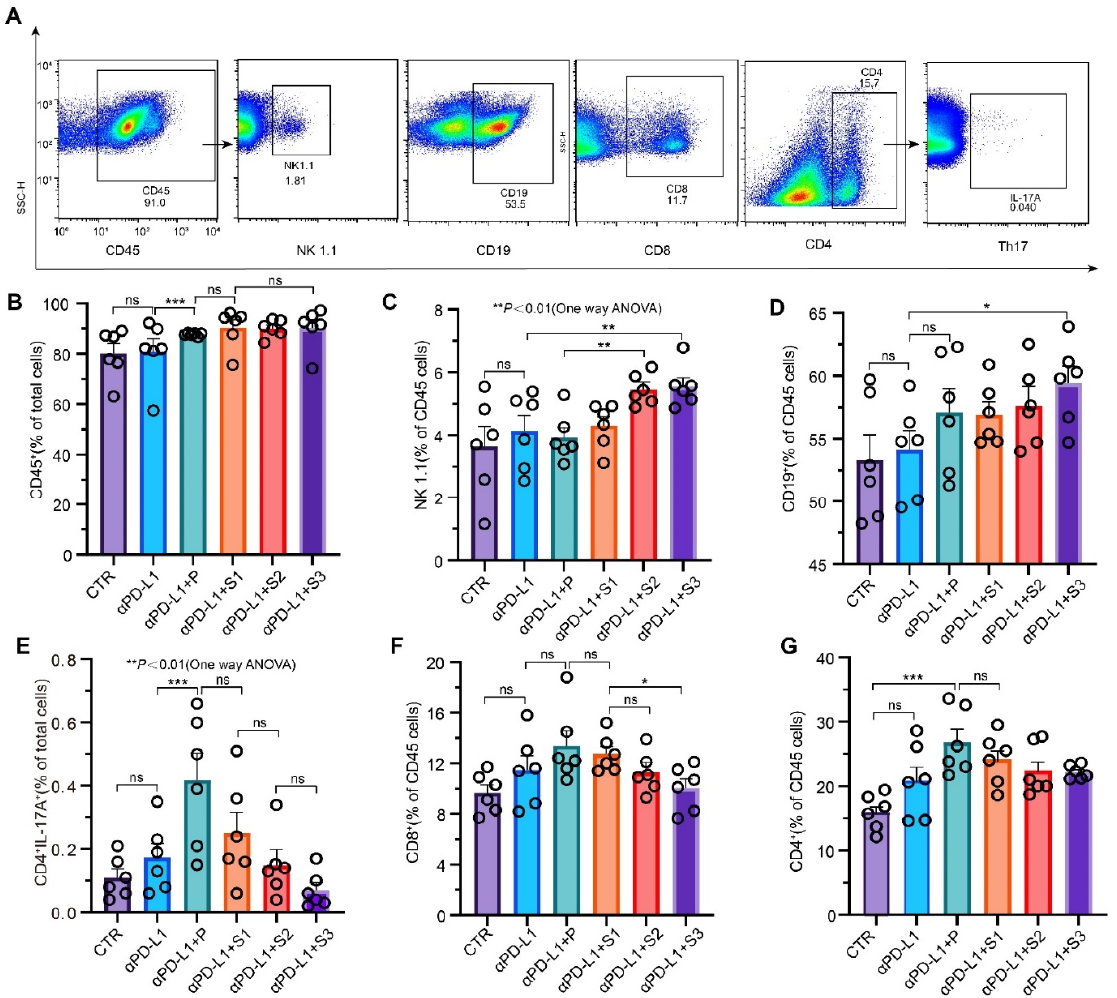
Figure 7. After administration with JP, the gut microbiota shows enhanced systemic immunity. ( A ) Representative flow cytometry plots showing the expressions of CD45, NK 1.1, CD19, Th17, CD4 + , and CD8 + T cells in spleen tissues; ( B – G ) percentages of CD45 cells, NK 1.1 cells, CD19 cells, Th17 cells, CD8 + T cells, and CD4 + Tcells in spleen tissues. Data indicate the mean ± SEM; * p < 0.05, ** p < 0.01, *** p < 0.001.